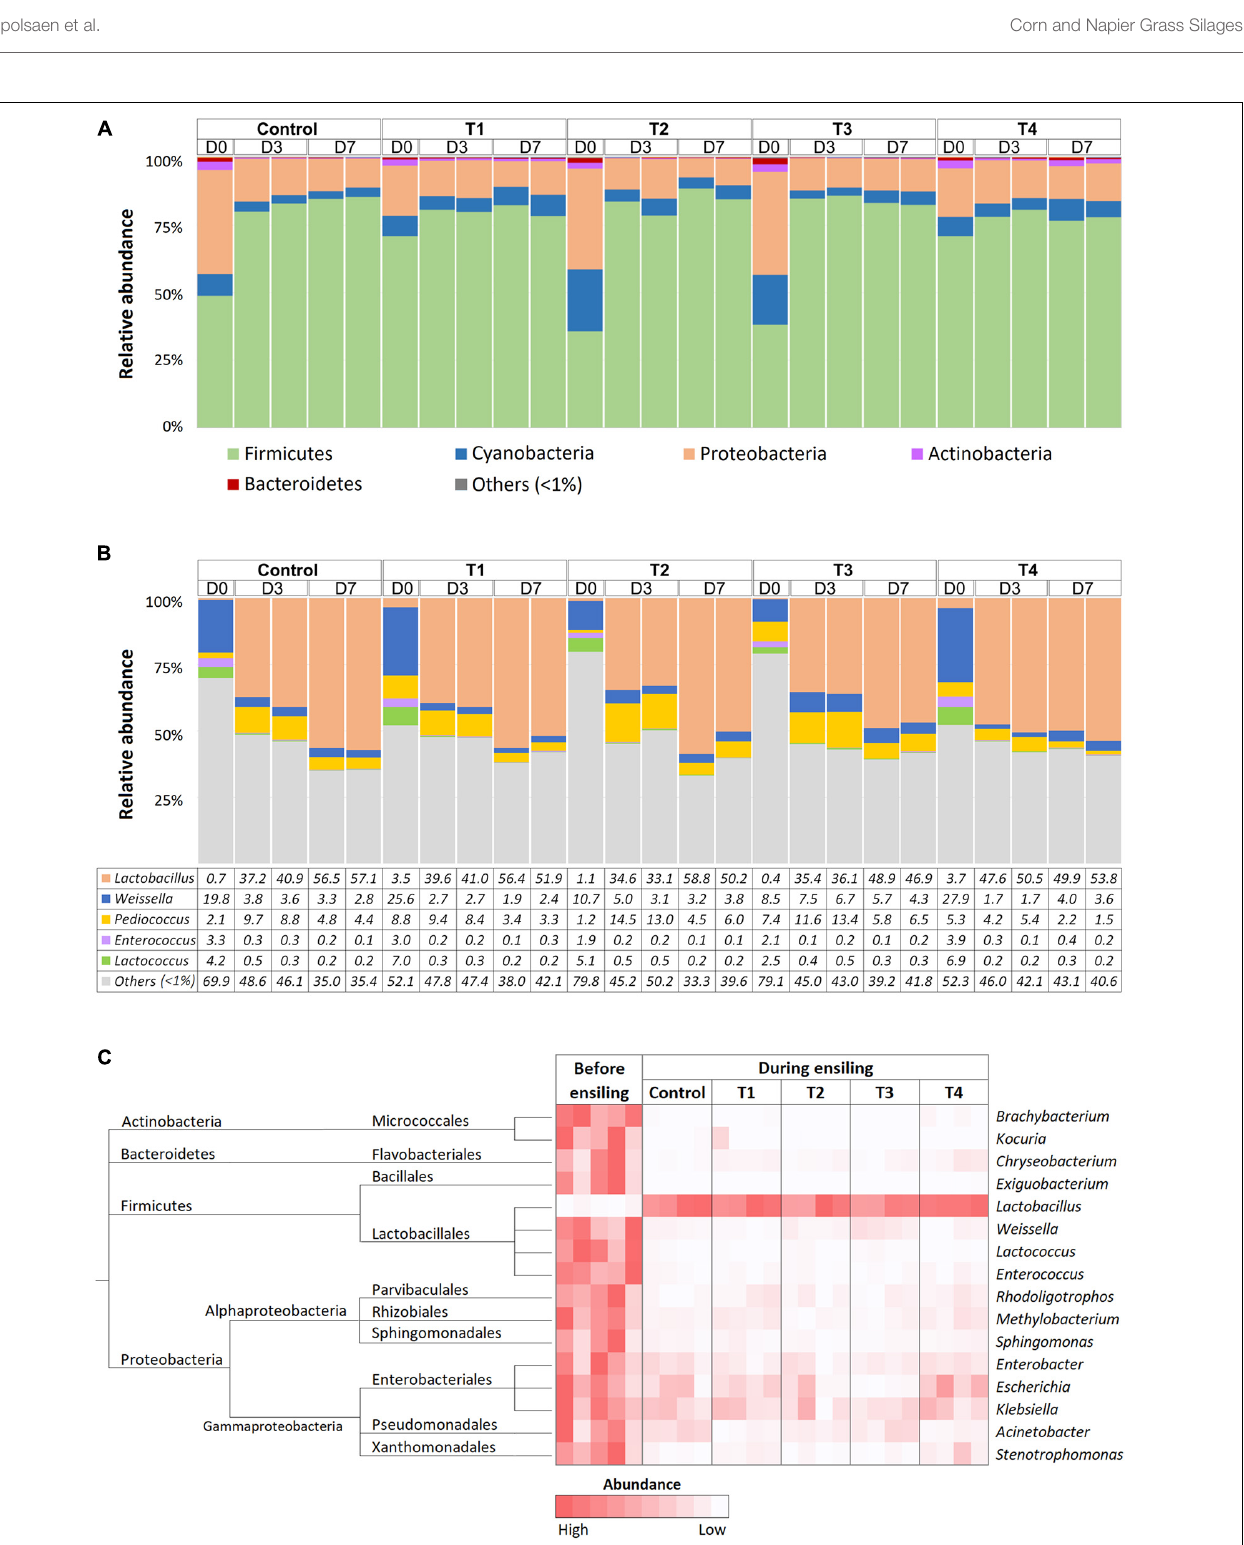
FIGURE 1 | Bacterial profiles of whole-plant corn silage in five treatment groups, which were a non-inoculated control group (control), and the groups inoculated with following starter inocula, Lactobacillus plantarum J39 (T1), L. brevis BCC42336 (T2), Pediococcus pentosaceus TBRC7603 (T3), and a combination of L. plantarum J39, L. brevis BCC42336, and P. pentosaceus TBRC7603 (T4). Silage was sampling on Day 0 (D0), Day 3 (D3), and Day 7 (D7) of ensiling. (A) Relative abundance of bacterial phyla. (B) Relative abundance of lactic acid producing bacteria genera. (C) Differences in bacterial profiles identified by Kruskal-Wallis H -test at ASV level. Taxonomic tree and heatmaps of microbiota based on the results of the comparison between treatment and control at D3 and D7 in corn plant silages. The significant ASVs with an adjusted p -value < 0.05 were shown in the heatmap.